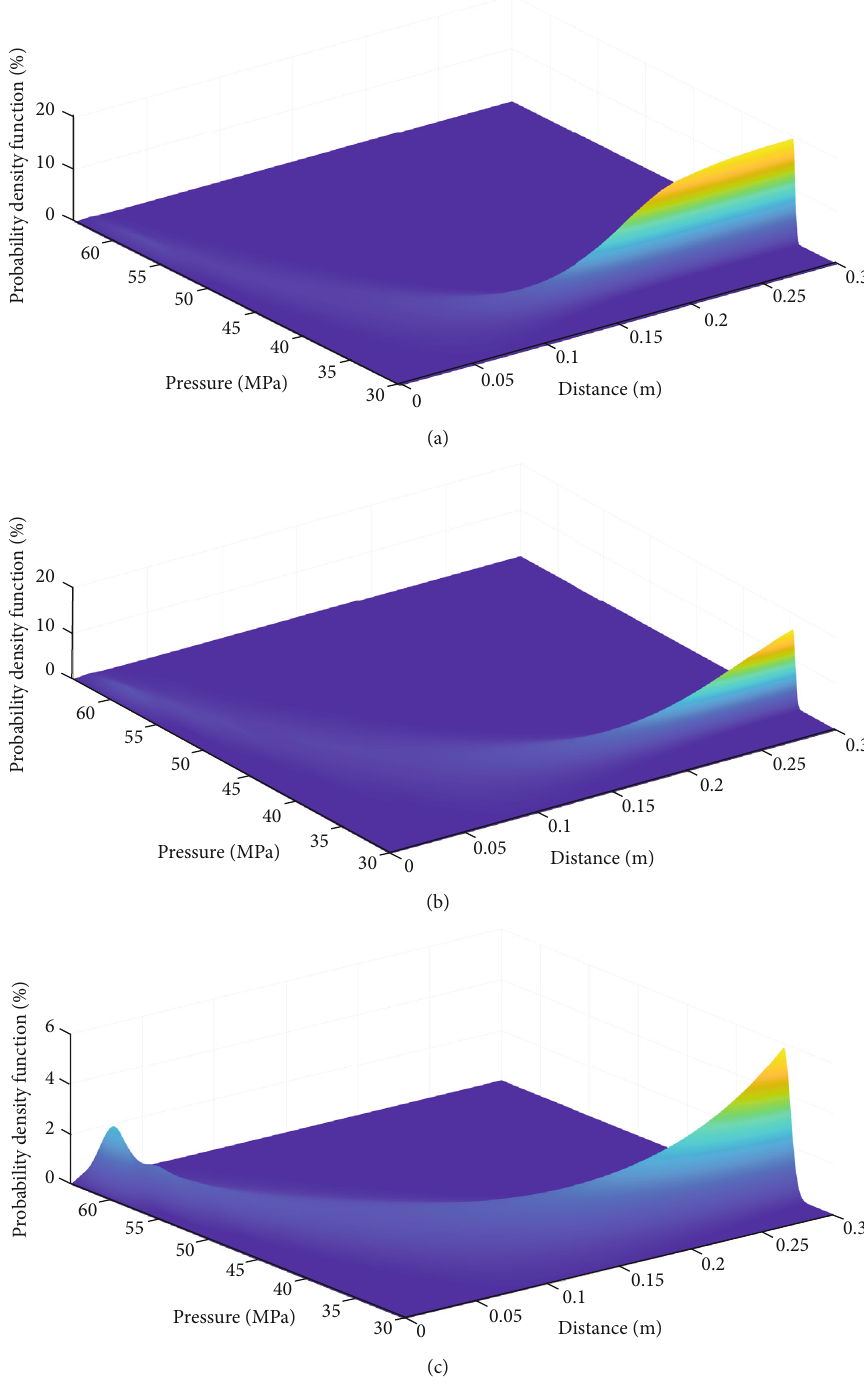
Figure 11: Probability density functions for pressure at times (a) t = 15 (min), (b) t = 30 (min), and (c) t = 60